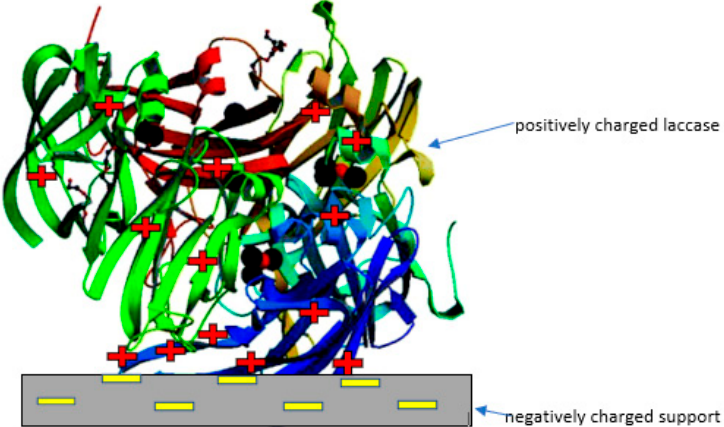
Figure 3. Schematic representation of immobilisation of laccase via electrostatic forces of attraction.